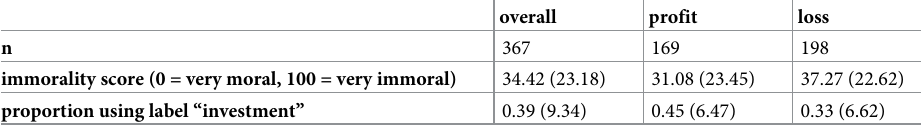
Table 2. Immorality scores and proportions using label “investment” by outcome.